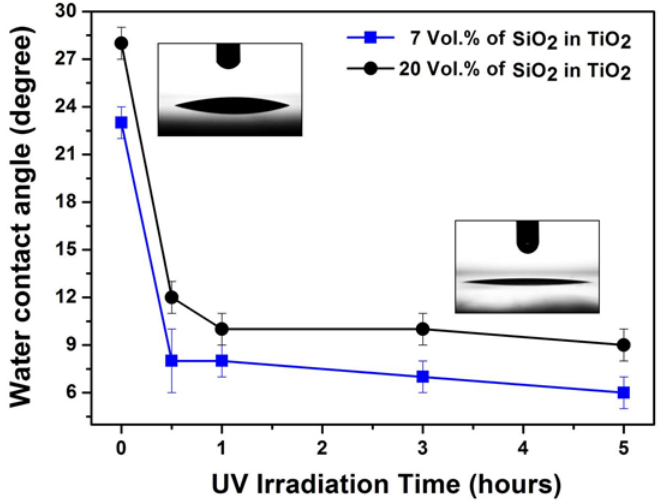
Figure 5. Wetting properties of the coatings prepared from 7 and 20 vol% of SiO (Insets shows the shape of water drops on